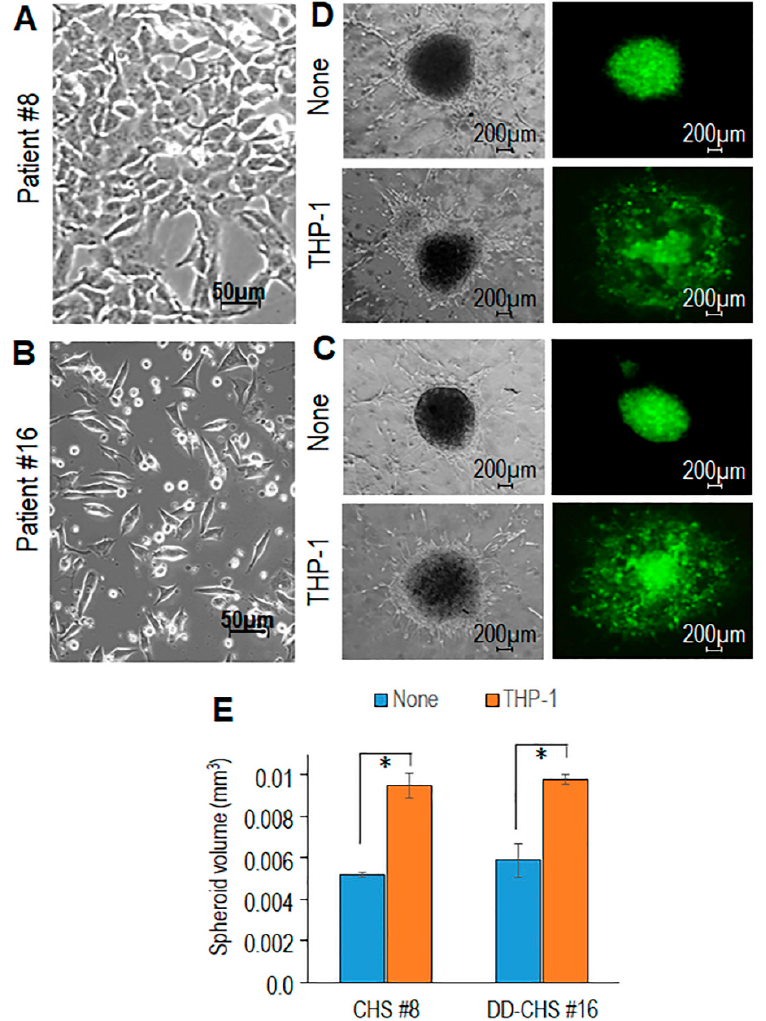
Figure 3. Contribution of THP-1 cells in promoting spreading of primary CHS cells in organotypic co-cultures. Primary CHS cells obtained from the tumor samples of #8 ( A ) and #16 ( B ) patients visualized by phase contrast microscopy. Original magnification: 200x. ( C , D ). Spheroids of GFP-tagged CHS cells ( C : patient #8, D : patient #16) were embedded in a collagen / fibroblast mixture, without (None), or with the addition of THP1 cells. Fluorescent and transmitted-light input images were acquired after 7 days at 50 × magnification. ( E ). Spheroid sizes assessed after 7 days by using the Equation (1), where D and d are the major and the minor diameter, respectively. Data are the mean ± SD of two independent experiments, performed in duplicate. Statistical significance with * p < 0.0001.